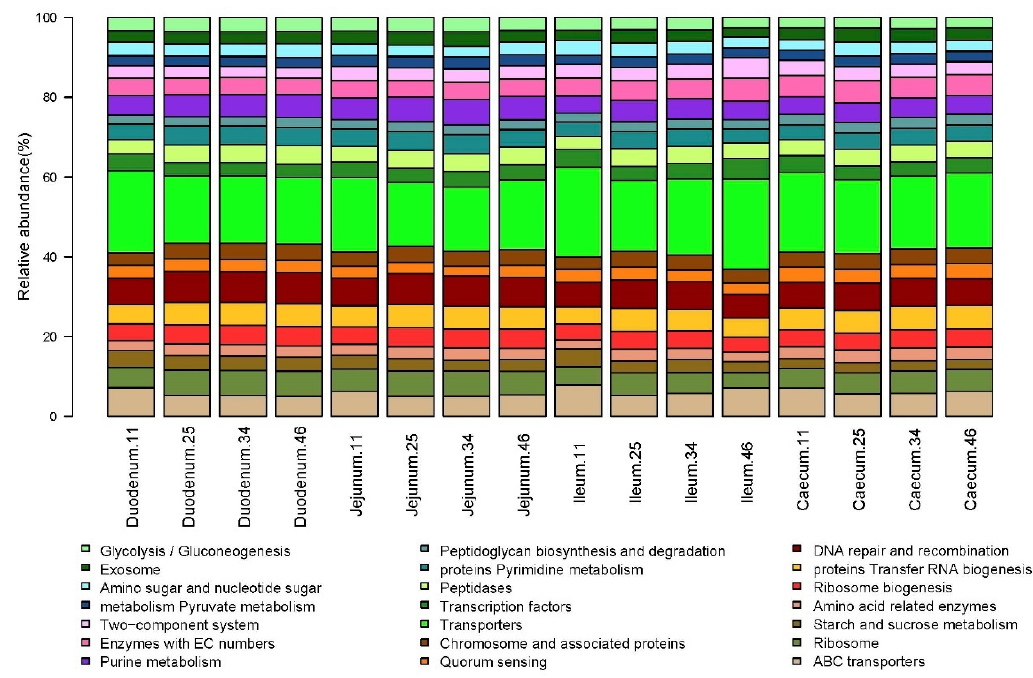
Figure 8. Relative abundances of pathways according to each day and intestine segment.